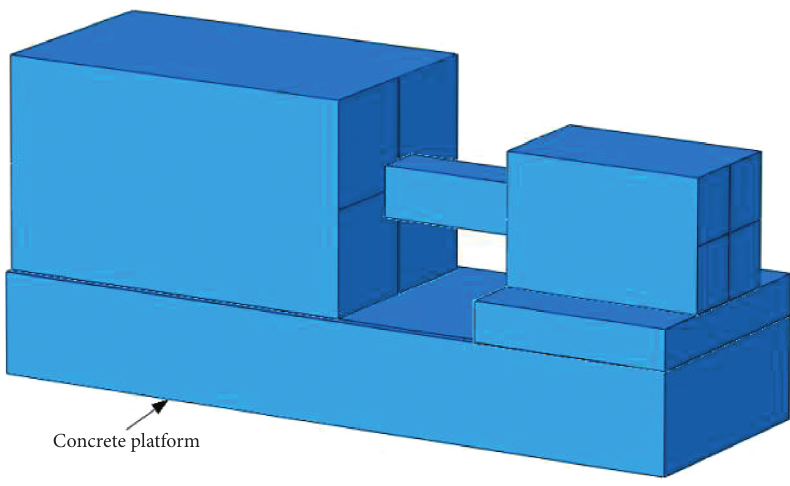
Figure 8: Concrete vibration-isolation Table 13: Comparison of vibration displacements between the steel platform and concrete platform.